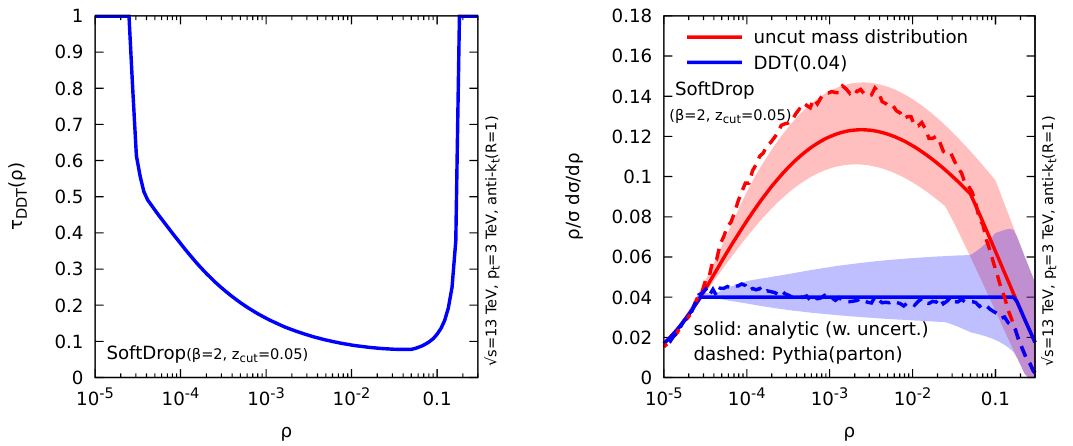
Figure 10 . Analytic construction of a decorrelated tagger (DDT). Left: cut on (cid:28) 21 which would give an analytic mass spectrum (cid:26)=(cid:27)d(cid:27)=d(cid:26) = 0 : 04. Right: resulting mass spectrum analytically (with an uncertainty band) and using